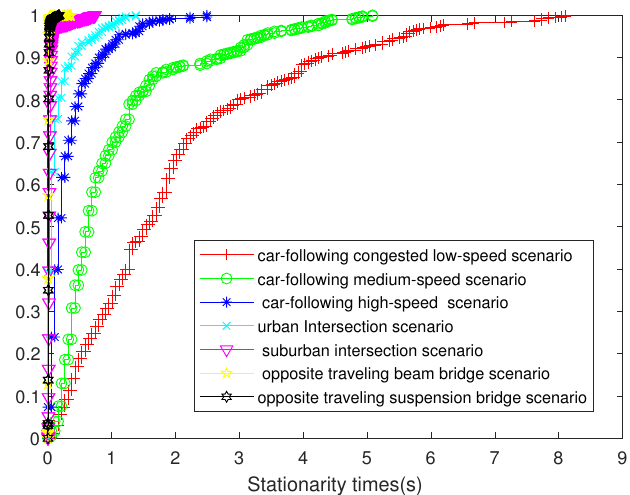
Figure 16. CDF of stationary times of the seven